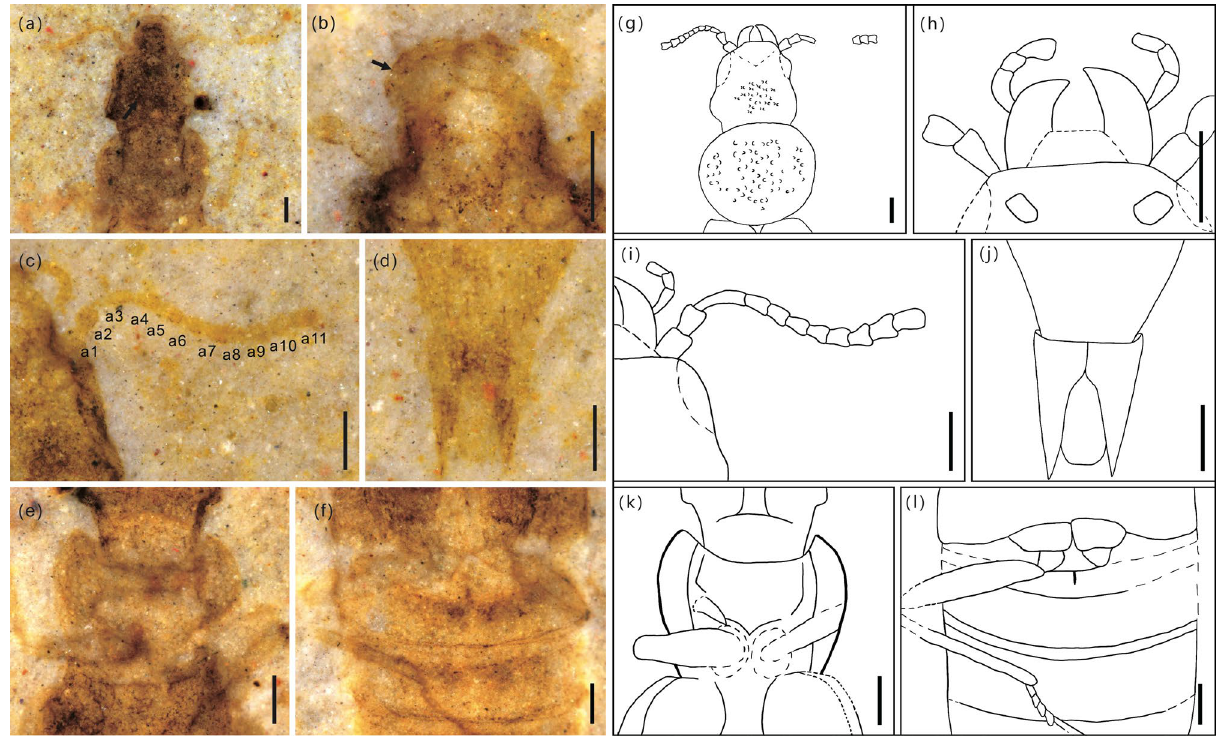
Figure 4. Morphological details of Cretaceonanobius fossilis gen. et sp. nov. (holotype, NIGP 177043). ( a ) Head, dorsal (arrow, punctation on head); ( b ) head, ventral (arrow, maxillary palp); ( c ) antenna; ( d ) latero-apical parts of segment X apex, ventral; ( e ) neck and procoxae; ( f ) metacoxae and metathoracic leg; ( g ) same as ( a ), line drawing; ( h ) same as ( b ), line drawing; ( i ) asame as ( c ), line drawing; ( j ) same as ( d ), line drawing; ( k ) same as ( e ), line drawing; ( l ) same as ( f ), line drawing. Abbreviations: a = antennomere; m = mandible; prc = procoxa. Scale bars = 200